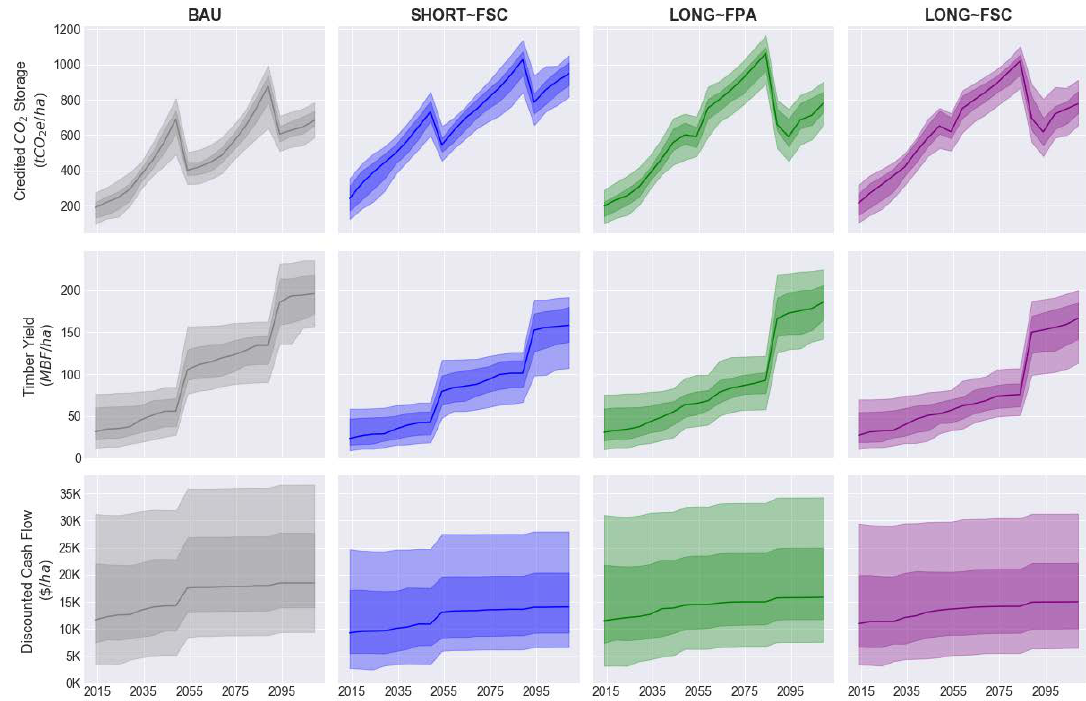
Figure 6. Dynamics of three KPIs over 100 years under four alternative management scenarios. The dark line in each graph represents the median value over time across the 64 parcels. The shaded areas correspond to the 25th–75th percentile range (darker), and the 10th–90th percentile range (lighter). Table 4. Isolated impacts of green tree retention and RMZ widths constraints on KPIs for each scenario. SHORT~FPA SHORT~FSC LONG~FPA LONG~FSC